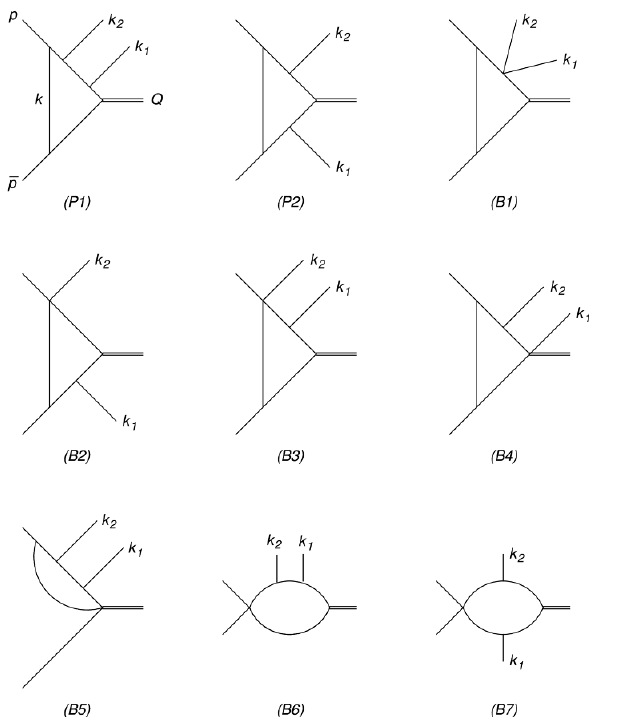
Figure 2 . Pentagon ( P i ) and box ( B i ) scalar master diagrams that contribute to eq.